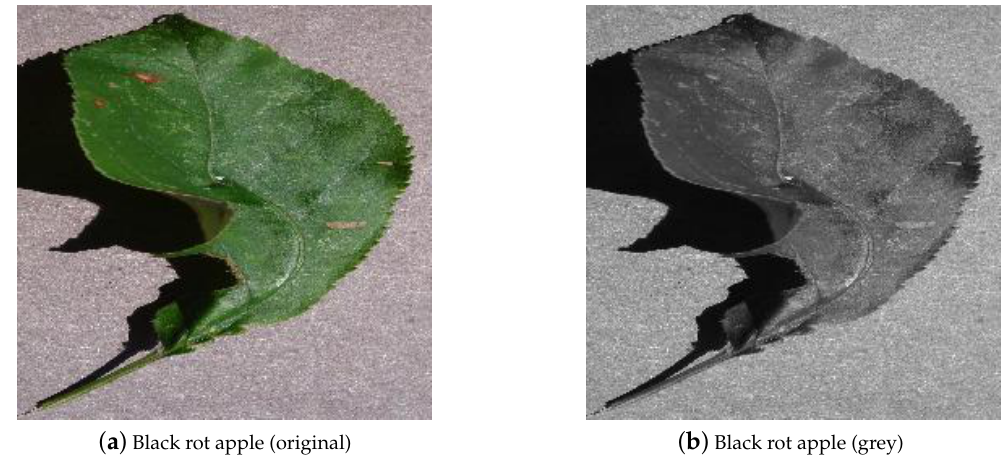
Figure 6. Example of an image converted to grey-scale from the PlantVillage data-set